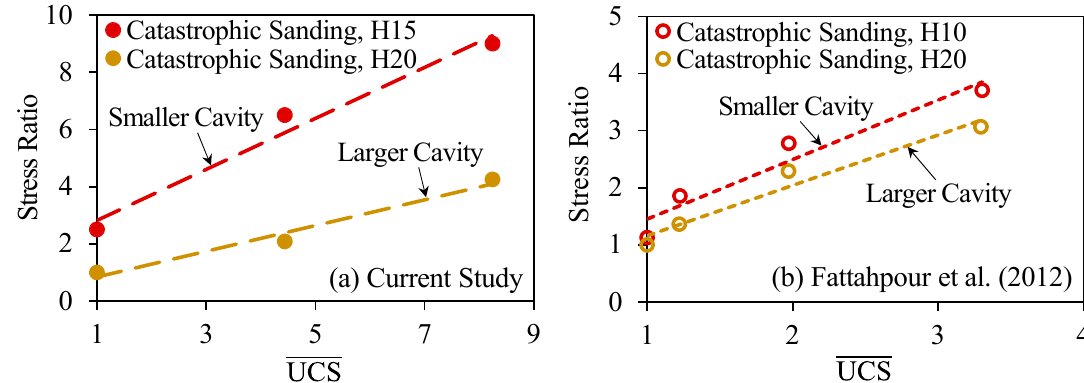
Figure 19. Variation of catastrophic sanding stress level with sample strength in: ( a ) The current study; and ( b ) the experimental study of Fattahpour et al. [2].